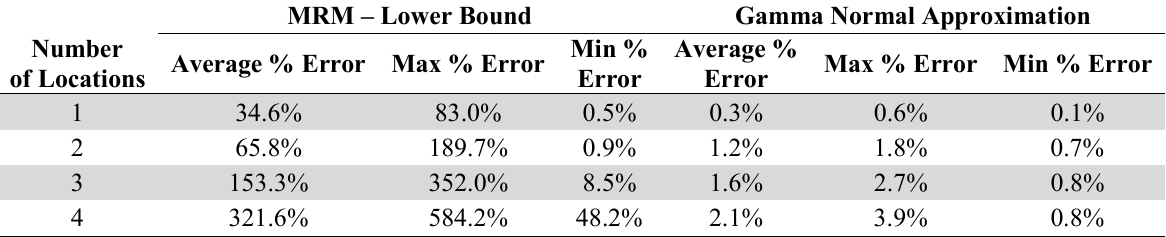
(𝑇|𝑁 ) for a very unreliable (cid:3036) (cid:3036)